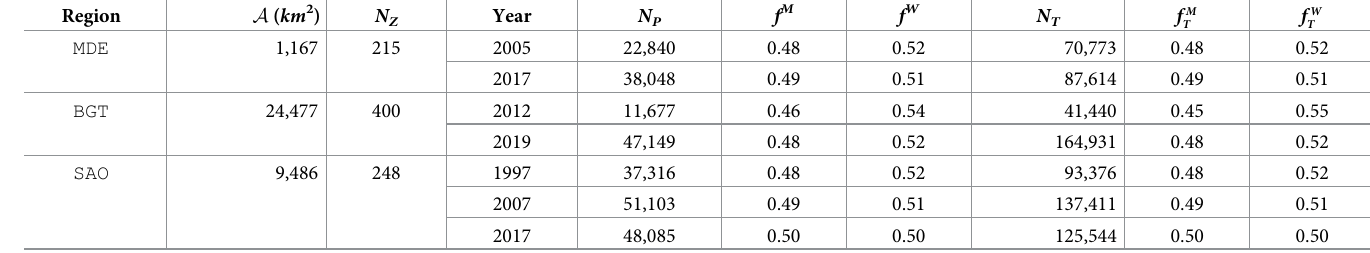
Table 1. Main properties of the raw datasets analysed in our study. For each region, we have the total area covered A , and the number of zones into which it is divided, N Z . Then, for each year we have the number of travellers N P , the fraction of men (women) travellers f M ( f W ), the number of travels N T , and the fraction of travels made by men (women) f M ( f W T T